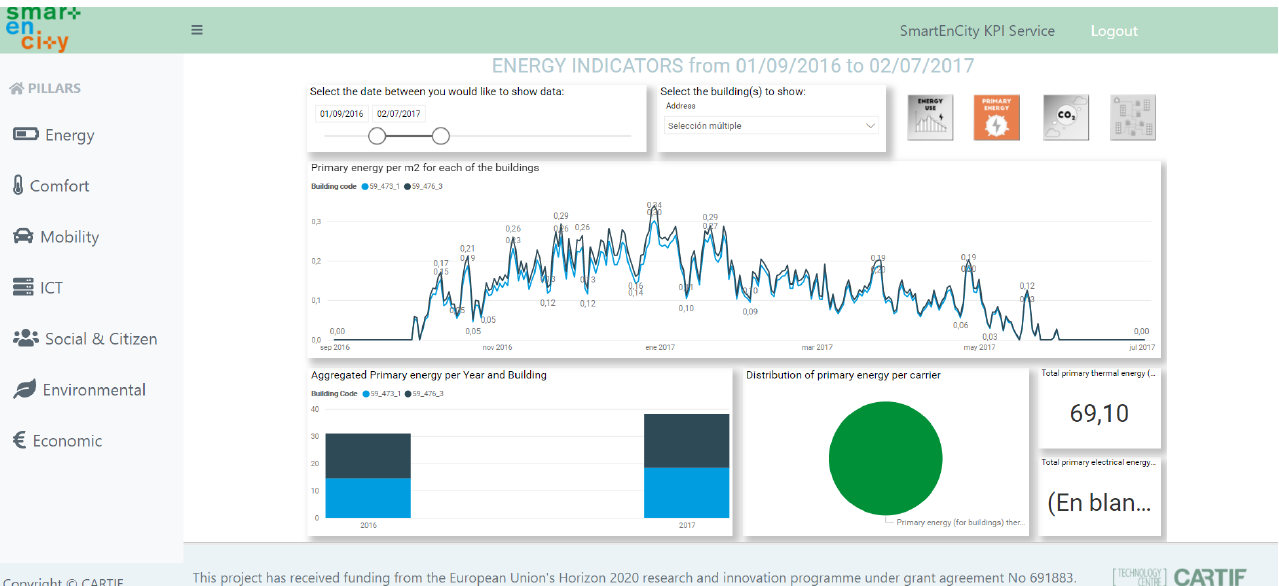
Figure 5. Dashboard for the energy indicators for selected buildings in the period of September 2016–June 2017. To represent all this information, a model of the city in CityGML format is gener- ated from the GIS (Geographical Information System) layer of the city and satellite data.